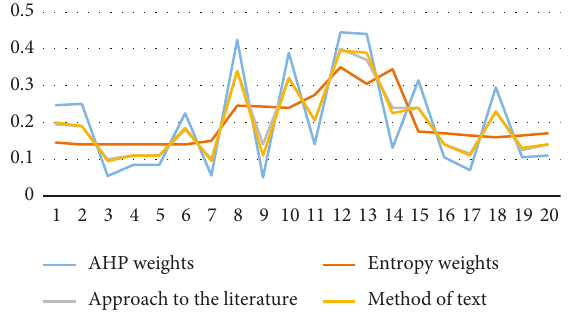
Figure 3: Comparison of the results of the four methods of obtaining weights.